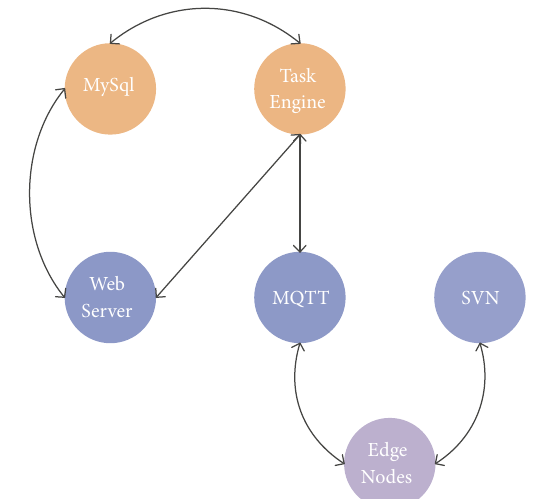
Figure 5: Servers in the cloud and their relationships. The servers include a task engine, an MQTT server, a MySQL server,a web server, and an SVN server.